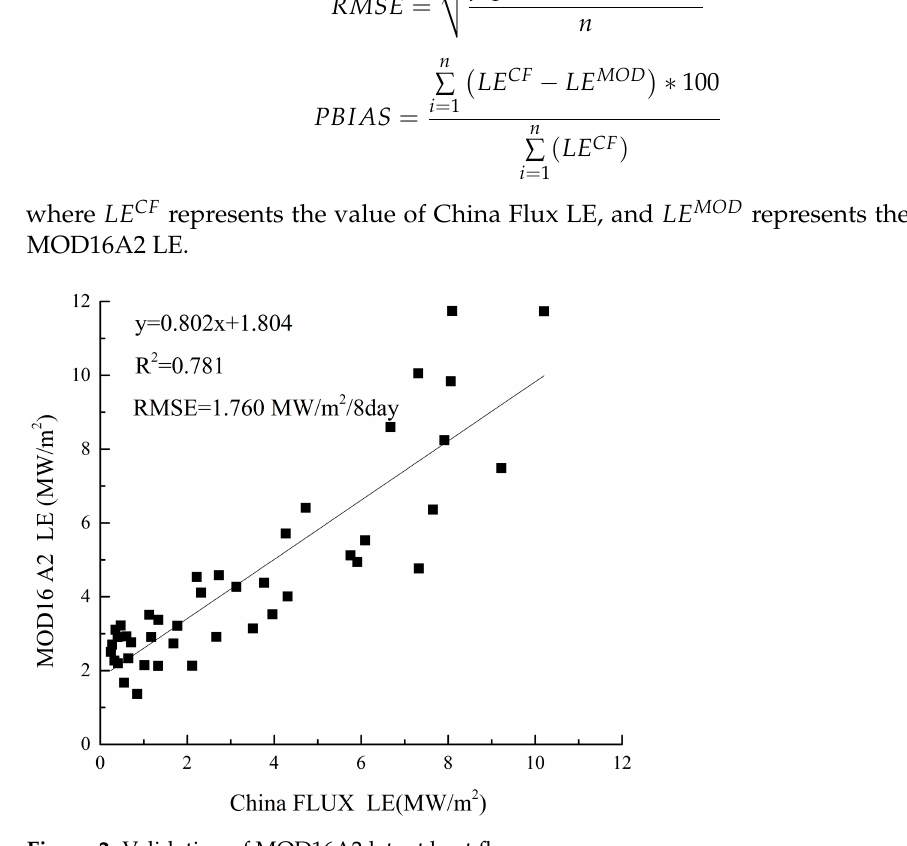
Figure 2. Validation of MOD16A2 latent heat flux. Table 1. Validation of MOD16A2 latent heat